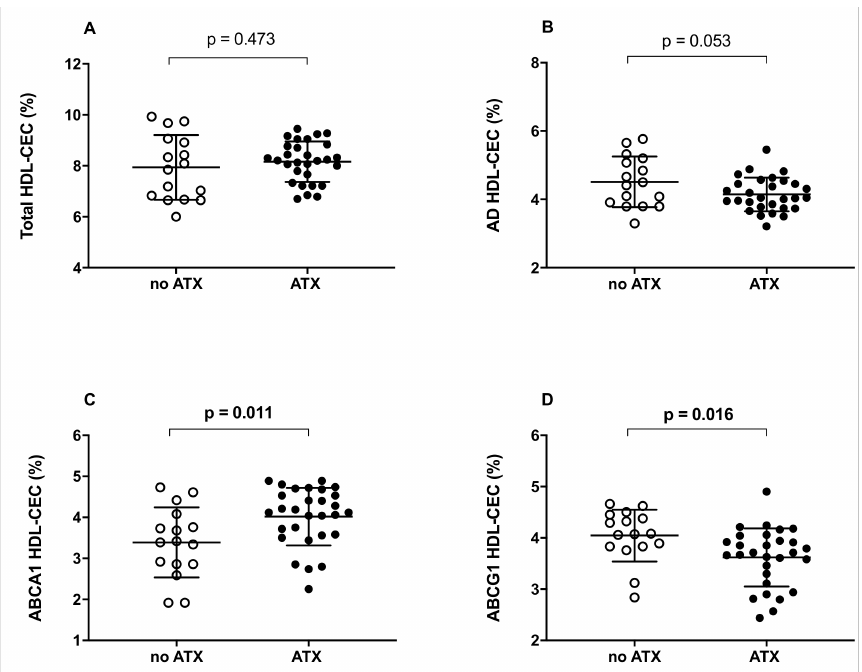
Figure 1. HDL cholesterol efflux capacity (CEC) in FH subjects not presenting or presenting ATX. ( A ): total HDL-CEC; ( B ): AD HDL-CEC; ( C ): ABCA1-mediated HDL-CEC; ( D ): ABCG1-mediated HDL-CEC. Each point of the graph represents the average percentage of triplicate analyses for each sample. The average of each group is represented by a horizontal, solid line.